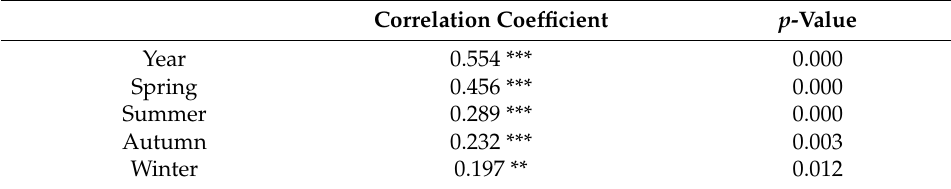
Table 2. The simple correlation of SPI and SWSI.